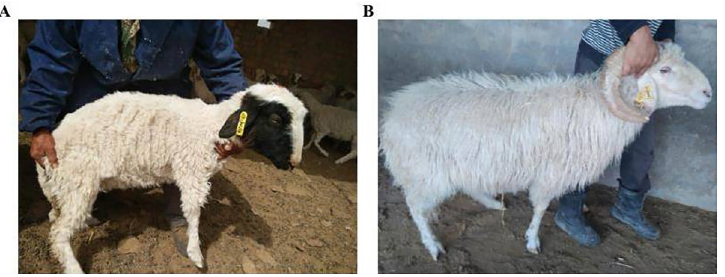
Fig 2. The coat colour phenotype of Chinese Tan sheep. (A) Shows white with black coat colour phenotype, whereas (B) referred to solid white coat colour